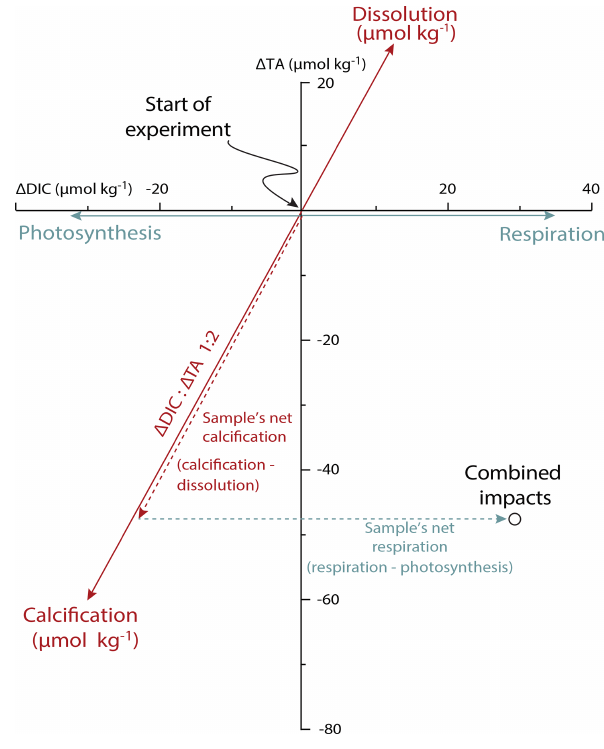
Figure 2. Calcification and net respiration of foraminifera deduced from changes in DIC and total alkalinity over time. The blue vec- tors show the impact of photosynthesis and respiration (impacting DIC); the red arrows show the impact of calcification and calcite dissolution (impacting both DIC and TA in a 1:2 ratio). Observed changes for each incubation should be decomposed into two vec- tors: a contribution of calcification (dashed red arrow) and the net effect of respiration and photosynthesis (dashed blue arrow). The approach is indicated here for a hypothetical